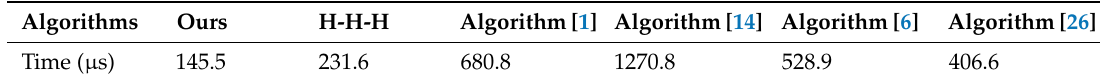
Table 14. Time comparison of various